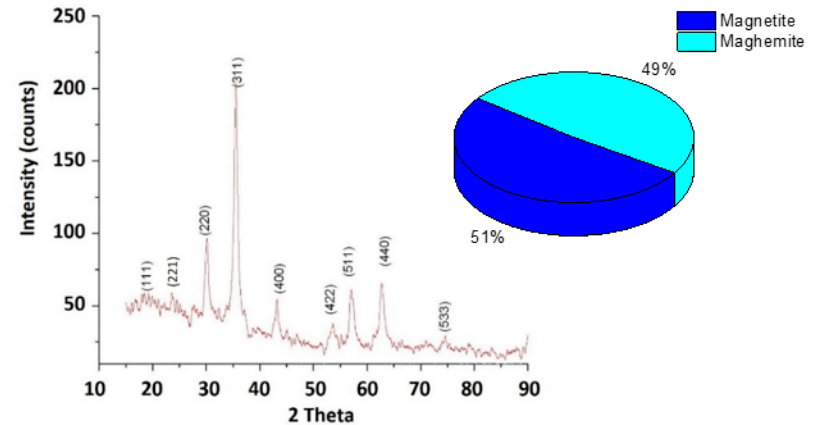
Figure 8. XRD results of the IONs powder.